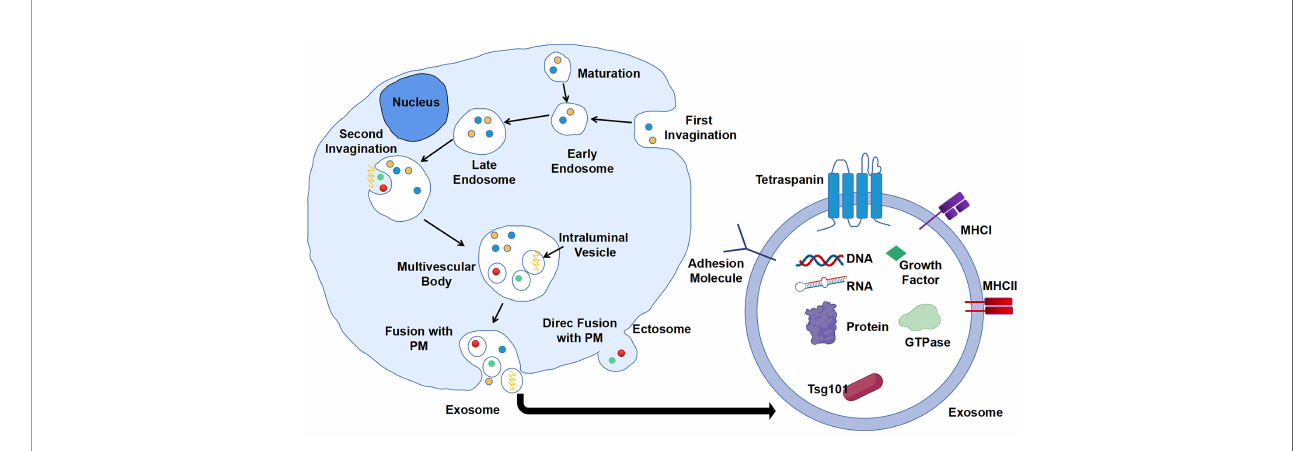
FIGURE 1 | Biogenesis and composition of exosomes. First invagination of plasma membrane (PM) forms the early endosomes that contain multiple constituents, which will then mature into late endosomes. Second, invagination of membrane of late endosomes generates multi-vesicular body (MVB) containing intraluminal vesicles (ILVs). ILVs are secreted into extracellular milieu as exosomes with cargos including DNA, RNA, and